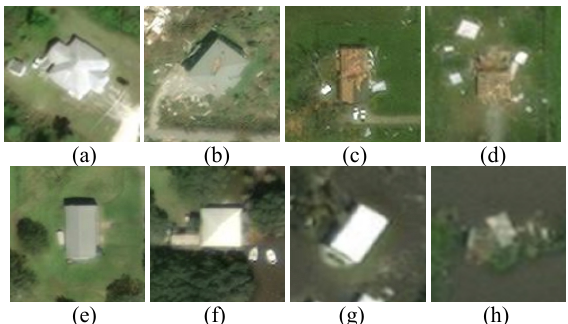
Figure 1 . Building morphology under each disaster damage